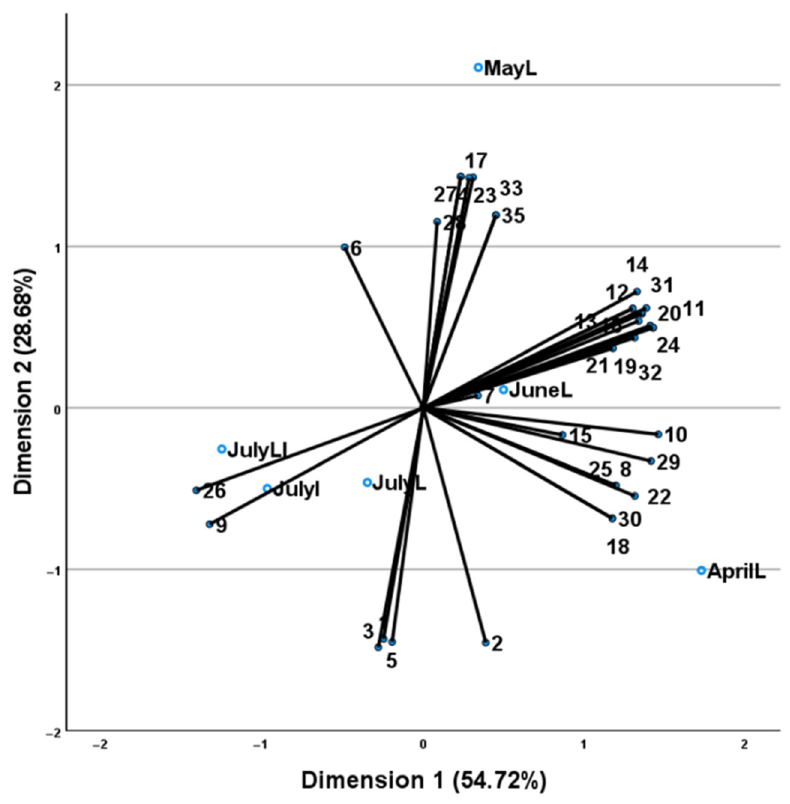
Figure 3. CATPCA analysis of the M. spicata leaves and/or inflorescences’ samples (coded as name of collection month followed by L for leaves, I for inflorescences and LI for leaves and inflorescences) based on their essential oil compounds (numbers of which correspond to those of Table 2). Axes 1 and 2, accounted for 83.40% of the total variability and the total value of Cronbach’s alpha (alpha = 0.994) indicated a high level of internal consistency.